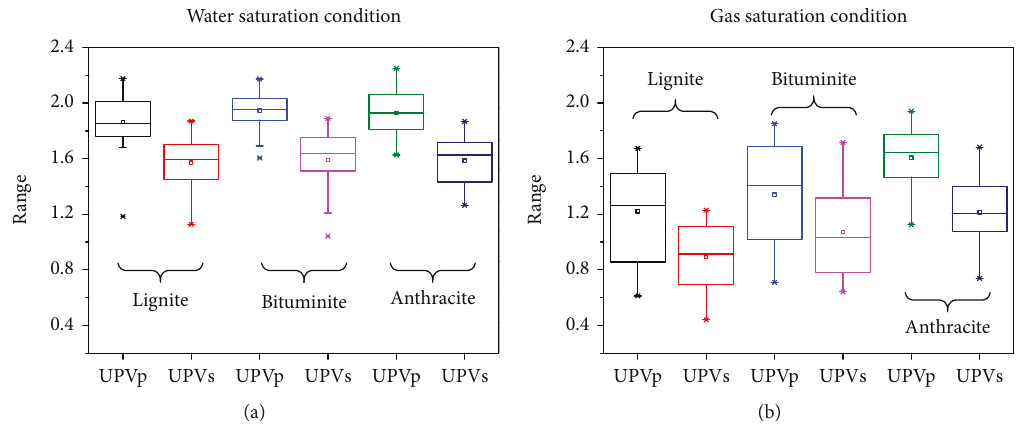
Figure 3: Box plots of di ff erent coal rank samples at (a) water saturation and (b) gas saturation condition.